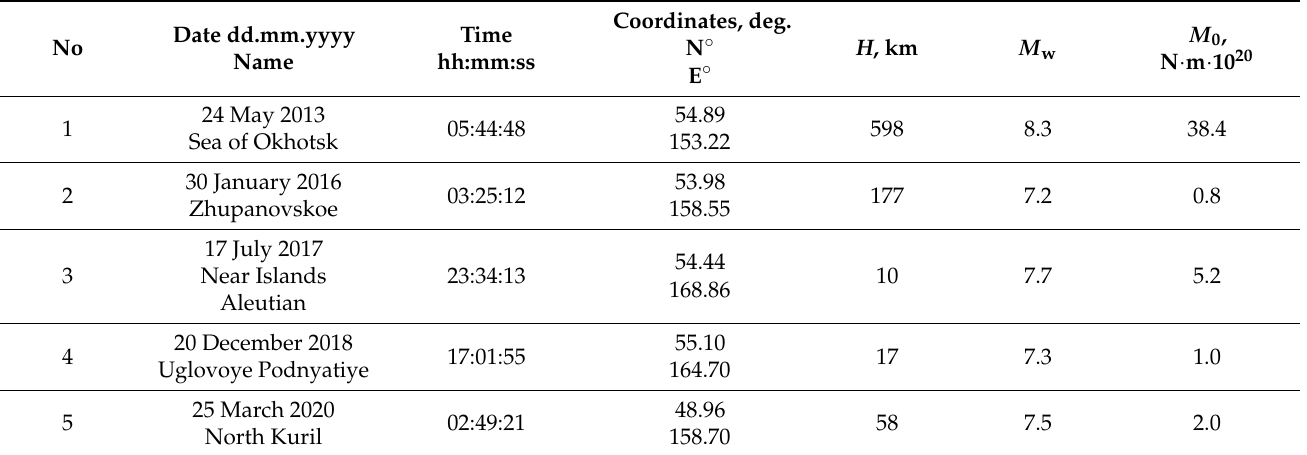
Table 3. Earthquakes with M w = 7.2–8.3 (http://earthquake.usgs.gov/earthquakes (accessed